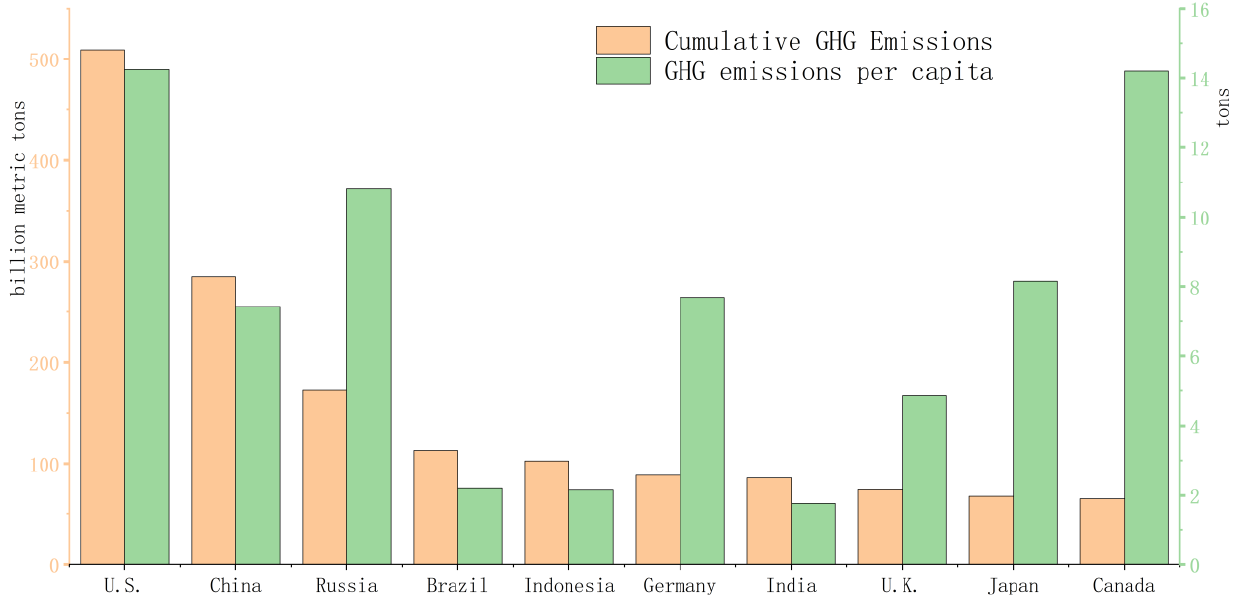
Figure 1. Top 10 countries with cumulative GHG emissions from fossil fuels, land use, and forestry from 1850 to 2021 and GHG emissions (CO₂ emissions from the burning of fossil fuels for energy and cement production) per capita in these countries in 2020 .